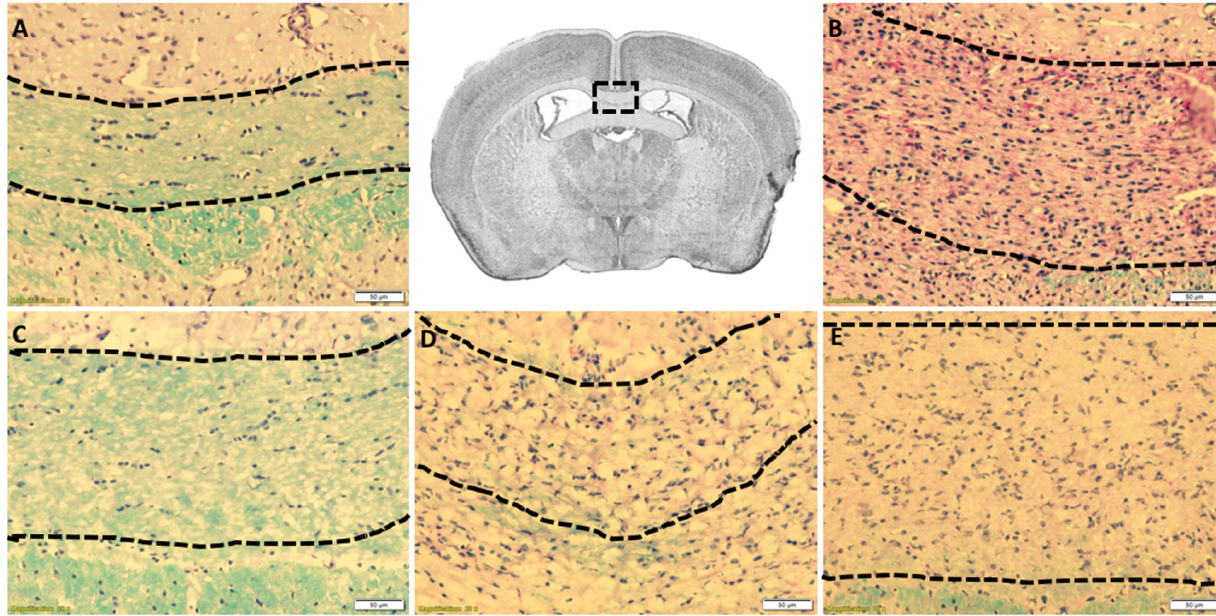
Figure 2. Cuprizone-induced demyelination of the corpus callosum in 18 F-PBR-111 injected mouse brain sections. Representative image in the first row, center box, demonstrates the area of analysis. LFB-PAS staining of control ( A ) and 18 F-PBR-111 injected ( B – E ) mice after 0 ( A , C ), 3.5 ( D , E ), and 5 weeks ( B ) after cuprizone treatment was used to analyze myelin levels (blue) and cellularity from MM (dark purple nuclei). Hand-drawn dotted lines represent the area in which scoring for myelin and cellularity was conducted. White scale bar represents 50 microns.